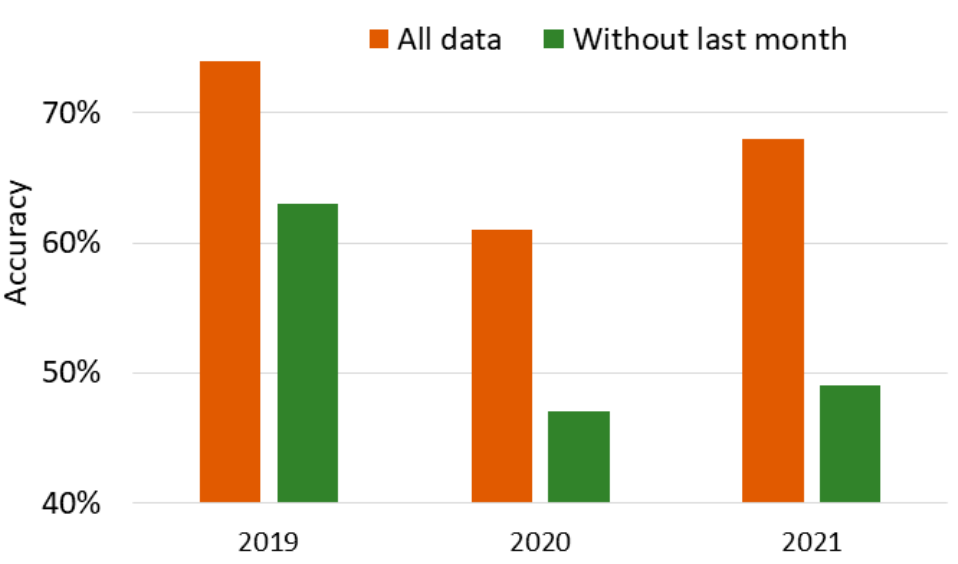
Figure 5. Accuracy in the classification of students’ performance for years 2019 to 2021 using a dataset that includes information from students in 2017 and 2018.